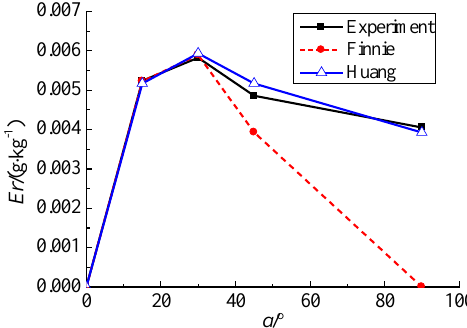
Figure 7. Erosion curve of impact angle on SA 210GrA1.